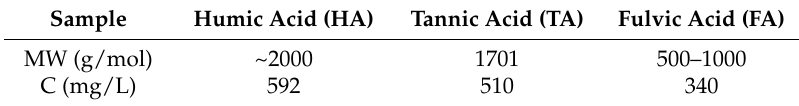
Table 1. Molecular weight of organic matter (OM) and their carbon